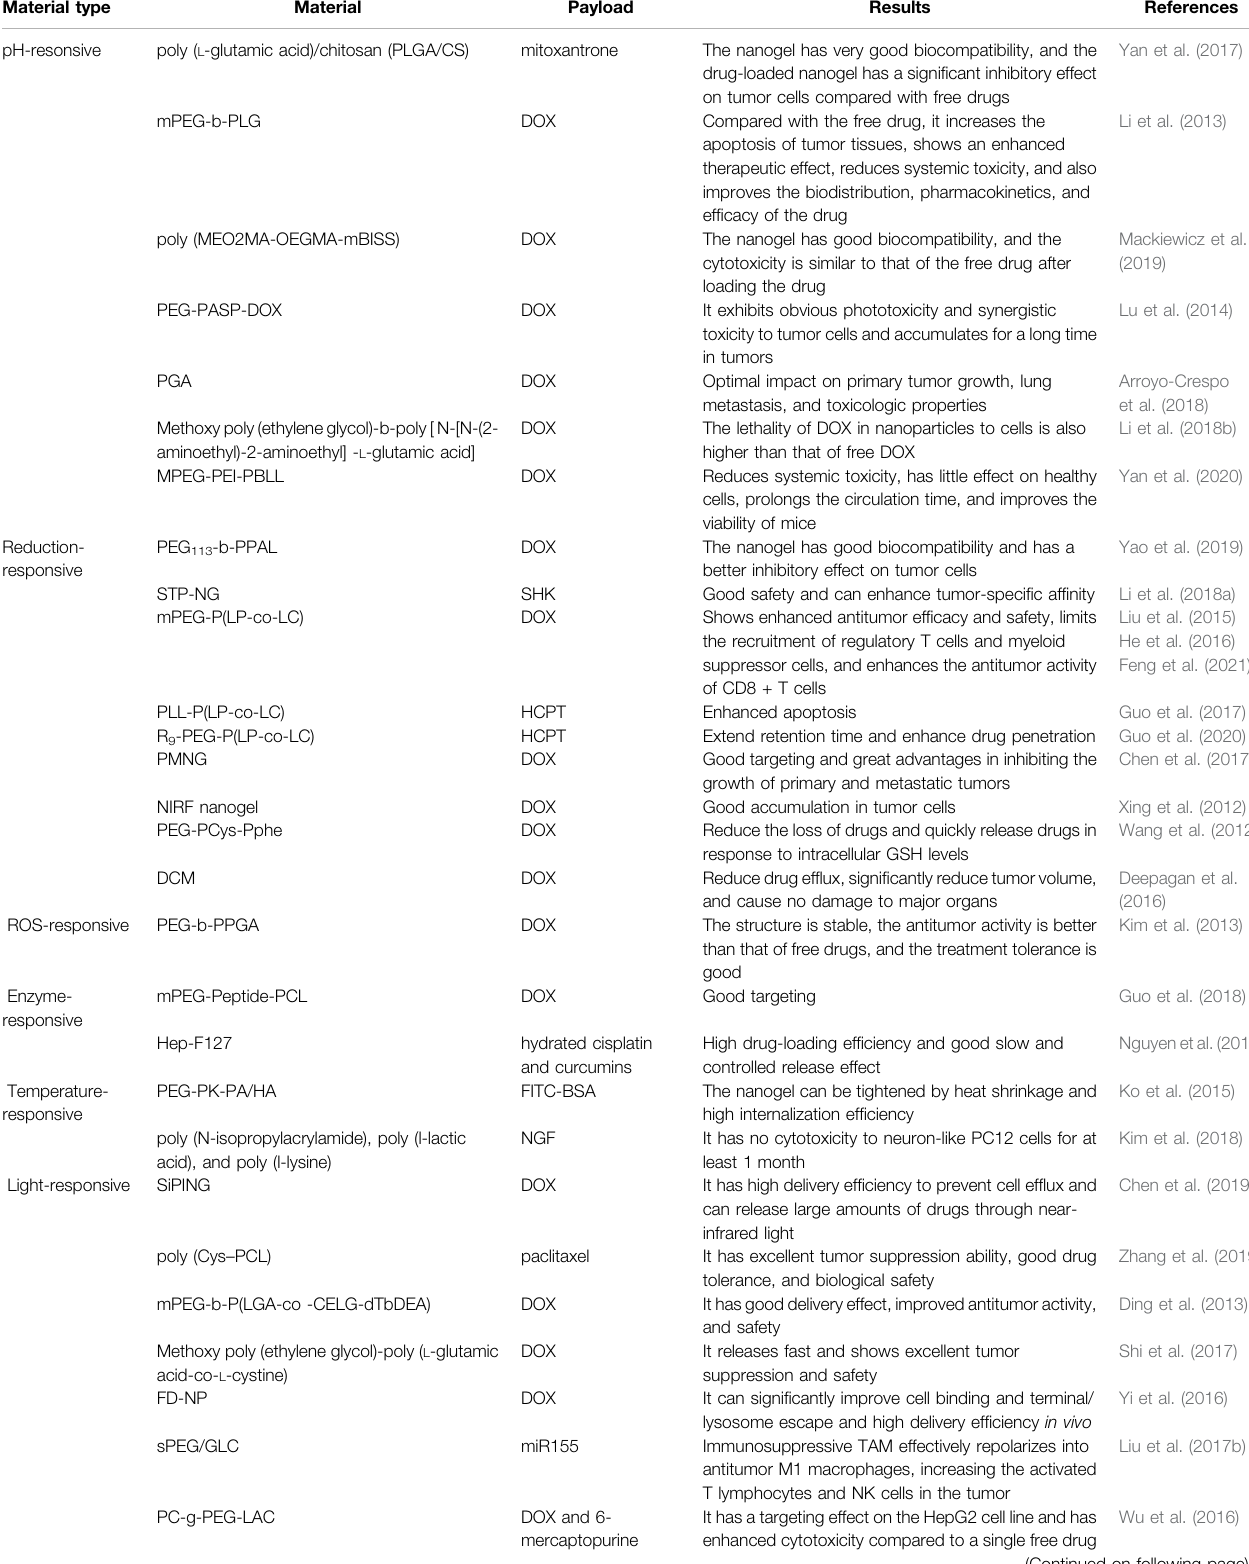
TABLE 1 | Tumor microenvironment – responsive polypeptide nanogels for controlled antitumor drug